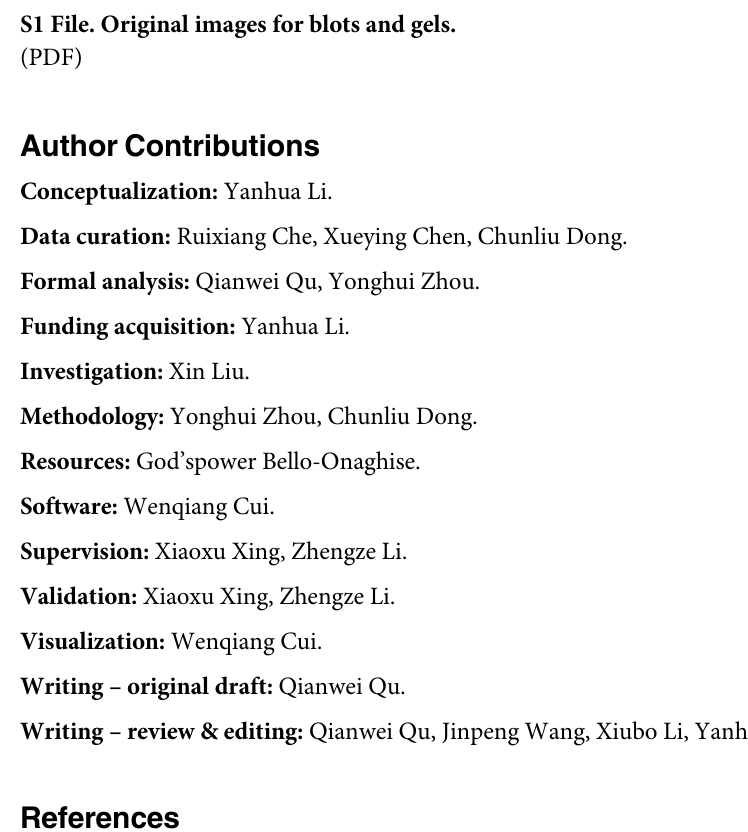
S1 Fig. Preparation of IGPD. (A) SDS-PAGE gel analysis of IGPD expression as induced